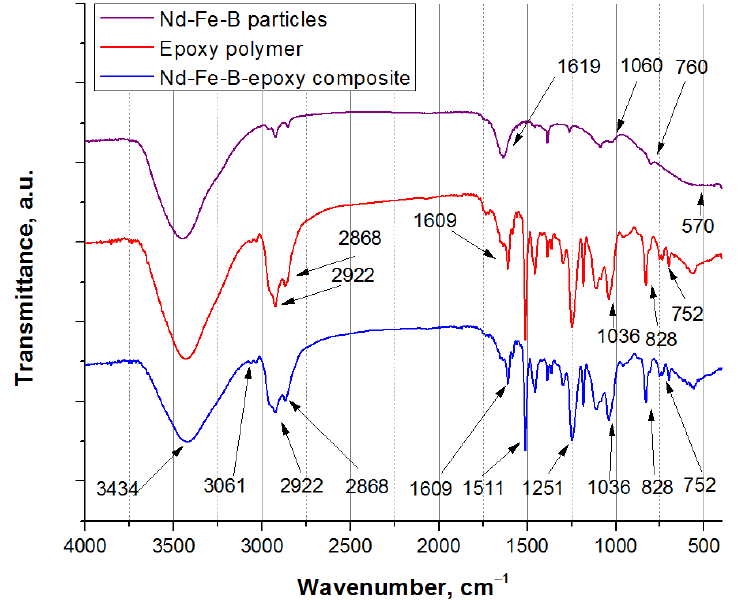
Figure 4. FT-IR spectra of composite material and components.